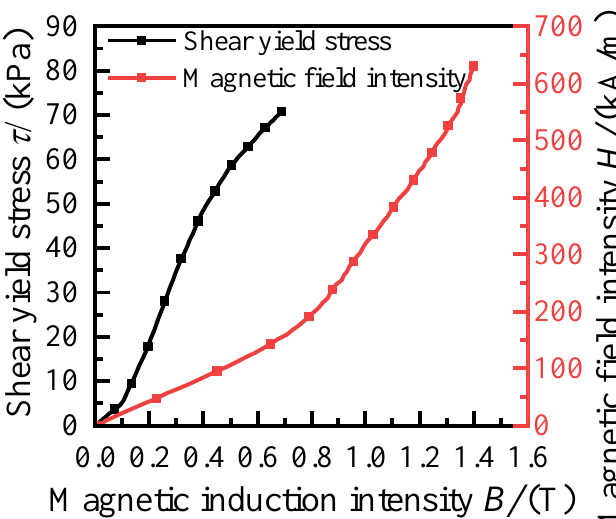
Figure 4. MRF (MRF-J01T) material characteristic curve. Based on the performance parameters of MRF in Figure 2, the relations between the magnetic induction strength, B , and the shear yield stress before squeeze, τ y ( B ), can be obtained with the fitting equation, as follows: According to the experiments of Liu et al. [18], it is known that the shear yield stress of the magnetorheological fluid increases exponentially when it is subjected to axial squeezing pressure. Among them, when the magnetorheological fluid is shear-deformed, the internal deformation of the magnetic chain is as shown in Figure